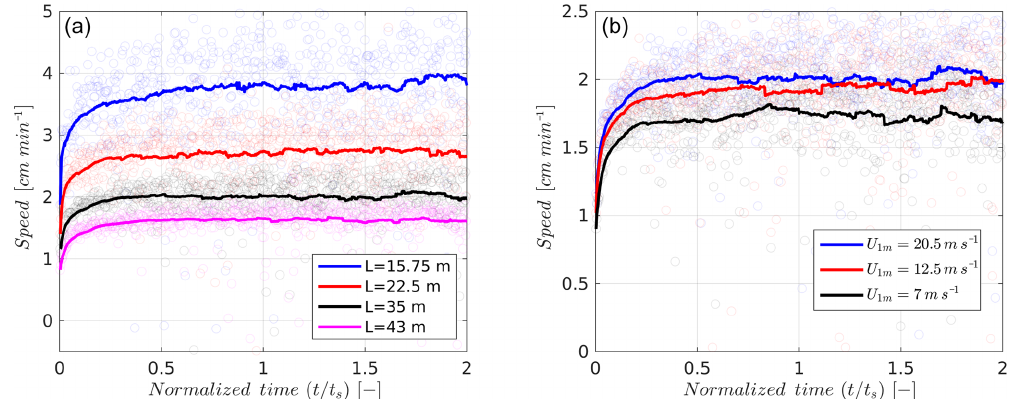
Figure 4. Influence of (a) dune length and (b) wind speed on dune velocity. The instantaneous speeds are represented by symbols while the time-averaged speed is shown by thick lines. The wind speed in (a) is the UH scenario whereas the dune in (b) is the cone